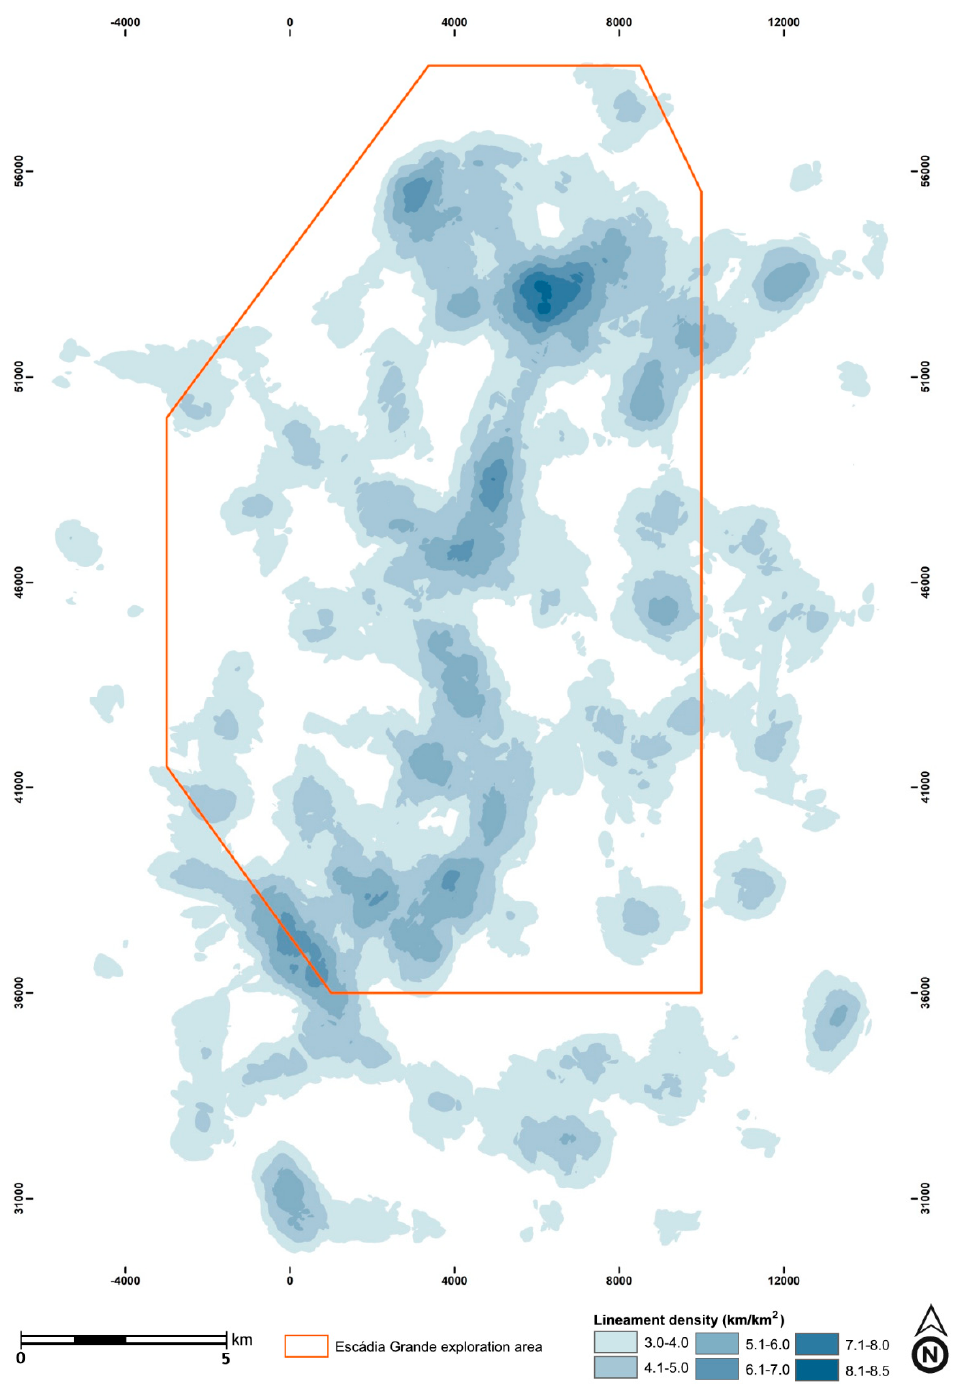
Figure 16. Lineament density map.